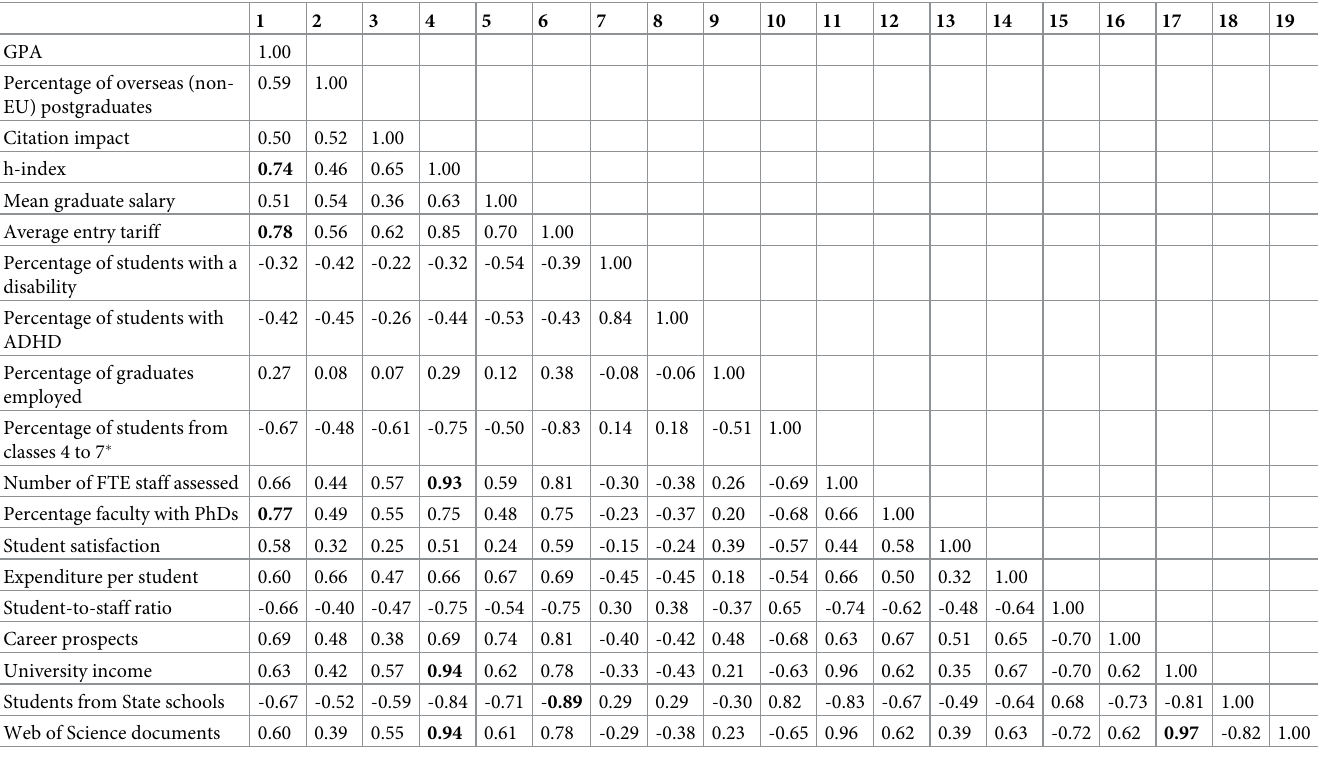
Table 1. Matrix of correlations in the training Set (n =